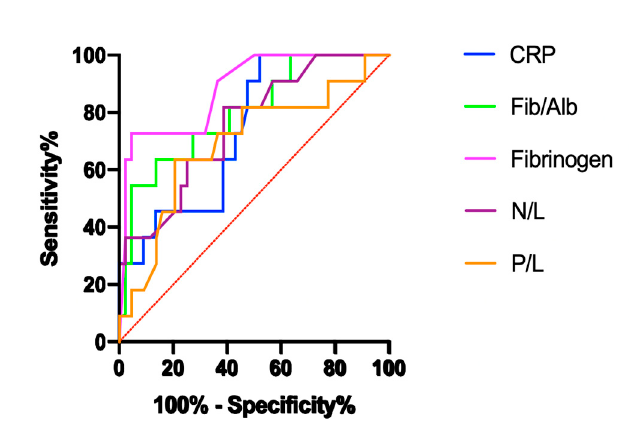
Figure 2. ROC analysis of parameters for patients with non-recurrent and recurrent IGM.